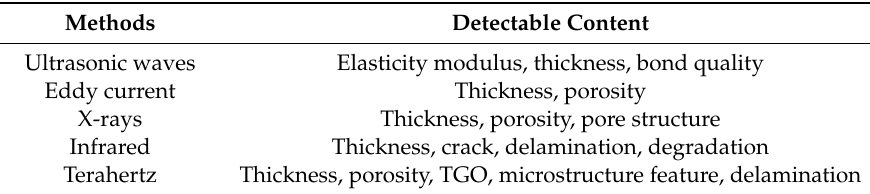
Table 1. Comparison of detection capabilities of di ff erent thermal barrier coating nondestructive testing